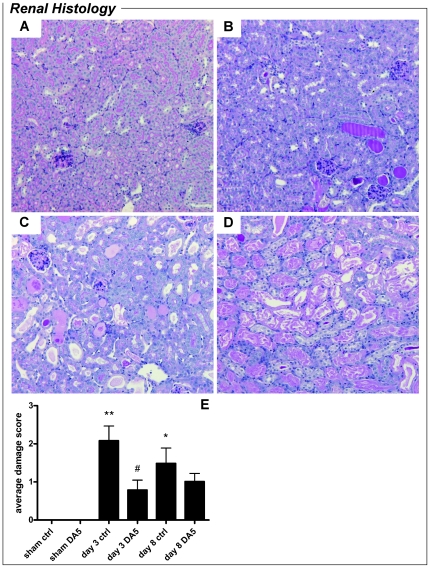
Diannexin (DA5) reduces proximal tubule damage after ischemia-reperfusion injury.(A–D) Representative images of PAS-stained kidney sections (magnification 100x), showing 4 levels of proximal tubule damage after I/R. (A) Damage score 0: intact brush borders and absence of casts or destroyed tubules. Damage score 1 (image not shown) was given for scattered cast formation in less than 1% of tubules. (B) Damage score 2: often clustered cast formation in 5–25% of the tubules. (C) Cast formation and destroyed tubules affecting 40–60% of tubules. (D) Damage score 4: Extensive destruction and cast formation in 70–90% of tubules. Damage score 5 (not observed): destruction or cast formation in 100% of tubules. (E) When compared to sham-operated mice, renal cortex damage was significantly increased in vehicle-treated groups on day 3 and day 8 post-I/R. Damage in the DA5-treated groups did not differ significantly from sham-operated mice on day 3 or day 8 post-I/R. On day 3, DA5 treatment significantly reduced renal damage when compared to vehicle-treated mice. Values are means ± SEM. *P<0.01, **P<0.001 vs. sham group; #
P<0.05 vs. ctrl group. n = 5 for sham-operated mice and n = 10 for all other groups.